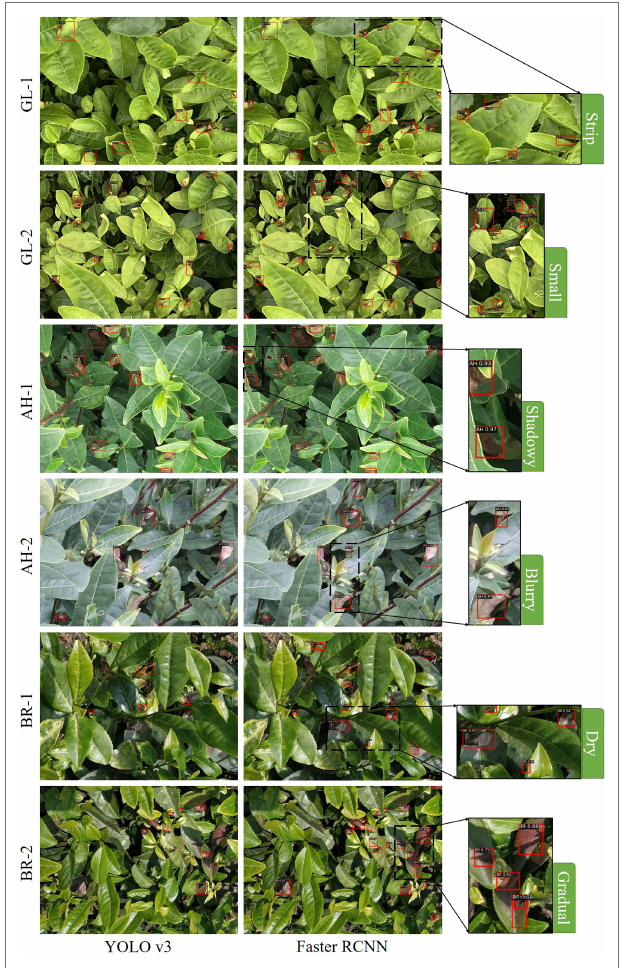
FIGURE 8 | Some difficult scenarios in tea plant stress detection.